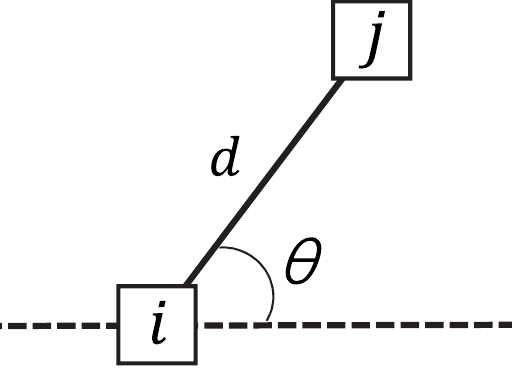
Figure 13. Parameters for calculating the gray level co-occurrence matrix to determine texture